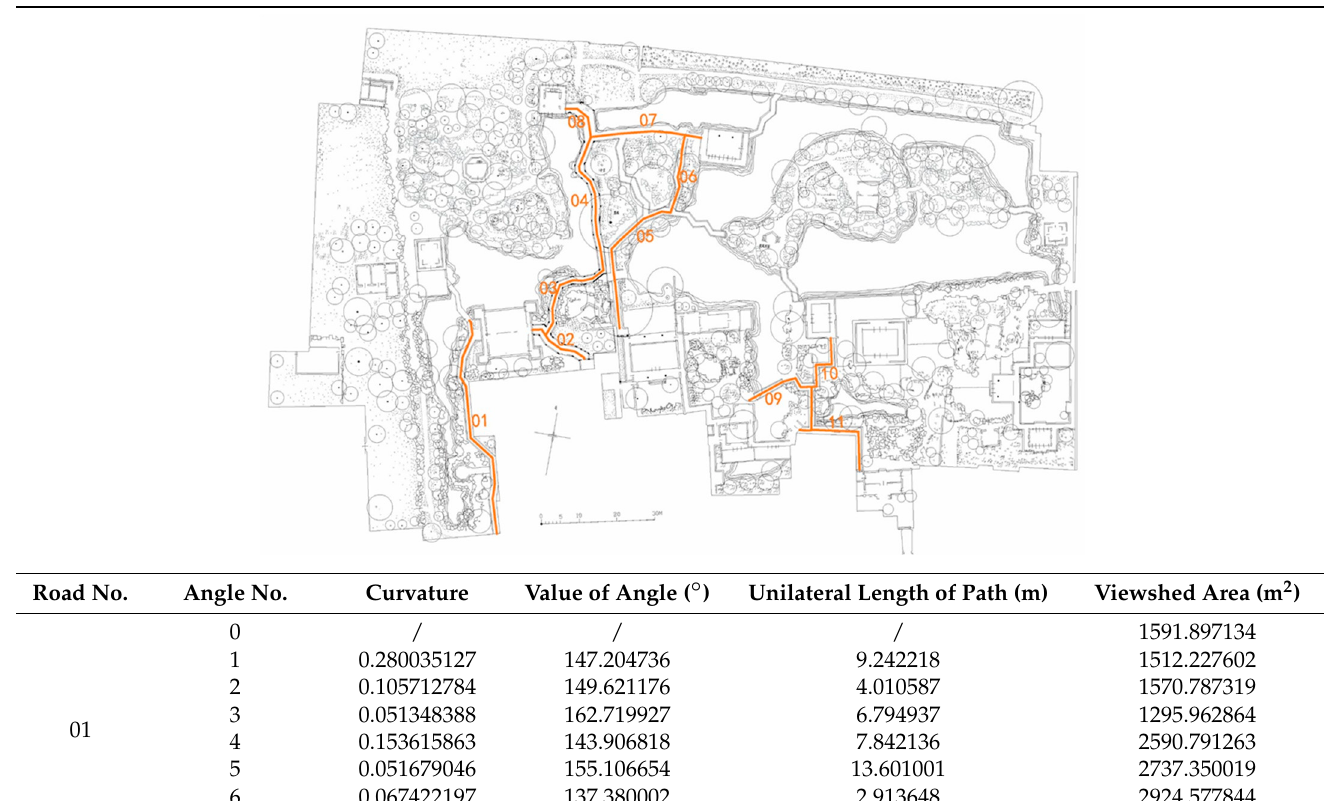
Table A11. Humble Administrator’s Garden, corridor.